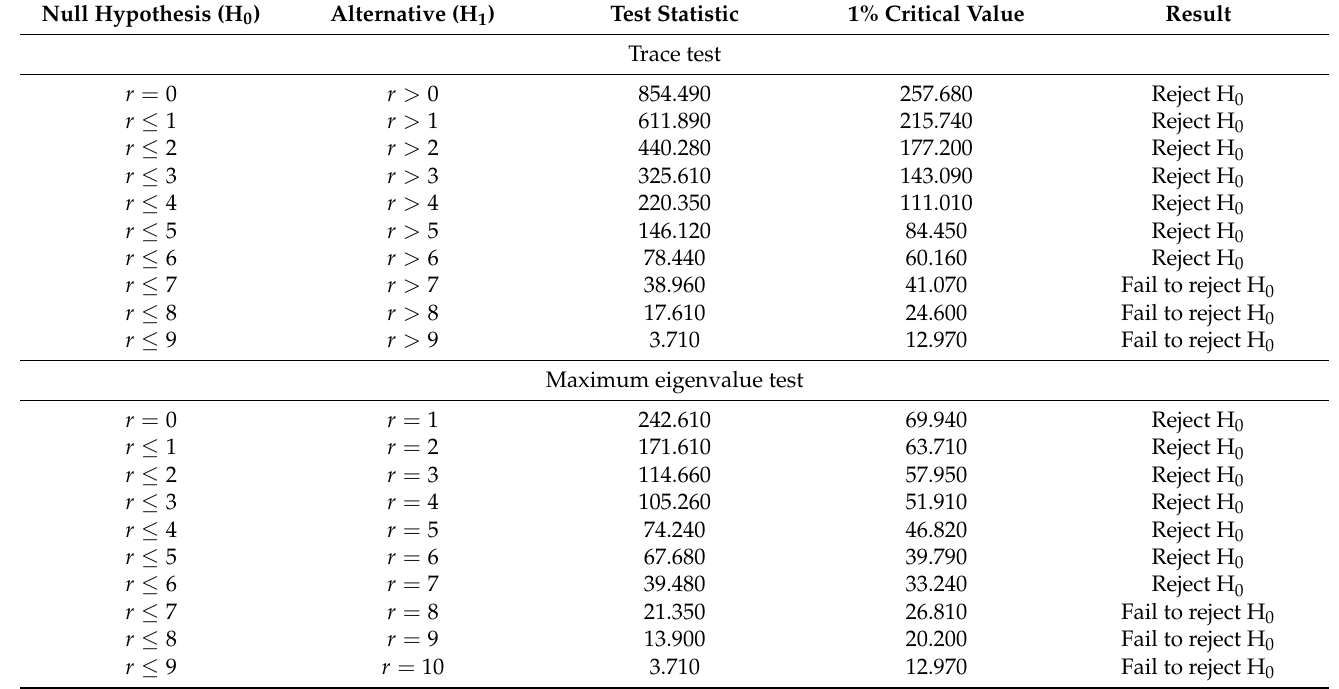
Table 5. Johansen’s trace test and maximum eigenvalue